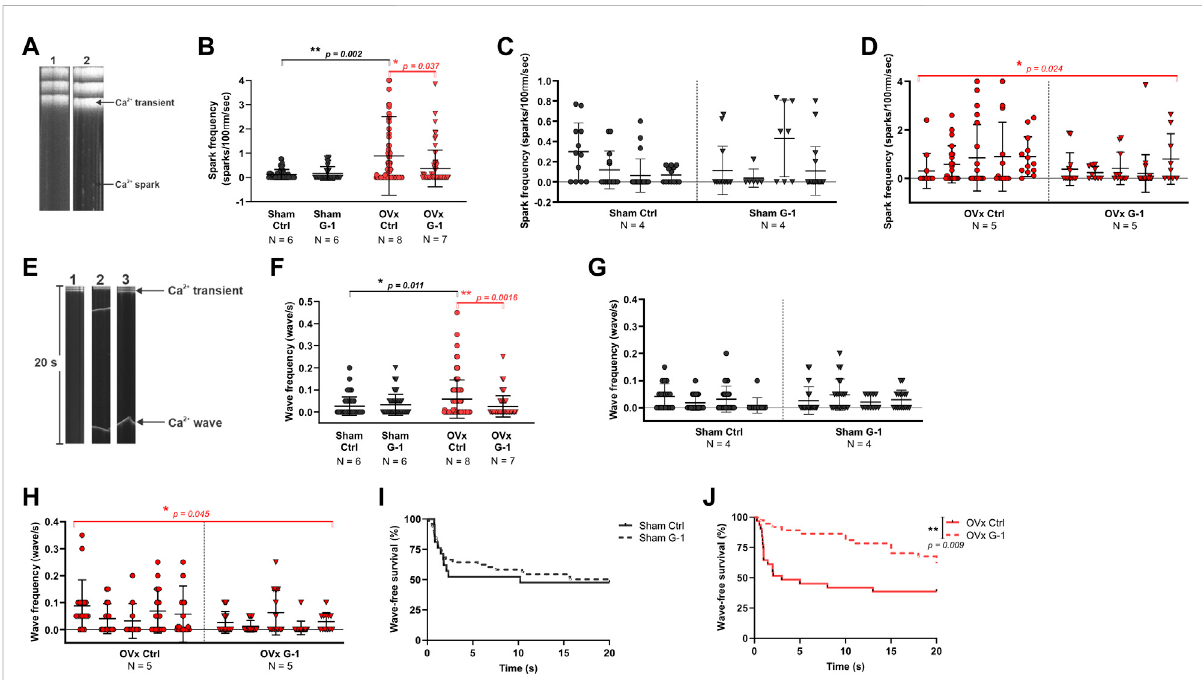
FIGURE 4 The effect of GPER modulation on spontaneous Ca 2+ release from the SR. (A) Line scan images of sham and OVx cardiomyocytes loaded with Fluo-4. (B) Spark frequency increased in OVx compared with sham and reduced following GPER activation in OVx cells. Mean ± SD. Mann-Whitney test.* p < 0.05,** p < 0.01,valuesasindicated. (C) Nestedanalysesofsparkfrequencyinshamand (D) OVxcardiomyocytesfollowingGPERactivation. Mean±SD.Nestedt-test.* p < 0.05,valueasindicated. (E) Linescanofcardiomyocytes withnowaves(image 1),multiplewaves(image2)anda singlewavewithlongerwave-freesurvivaltime(image3). (F) WavesfrequencyincreasedinOVxcomparedwithshamanddecreasedfollowingGPER activation in OVx. Mean ± SD. Mann-Whitney test. * p < 0.05, ** p < 0.01, values as indicated. (G) Nested analyses of wave frequency in sham and (H) OVx following GPER activation. Mean ± SD. Nested t-test. * p < 0.05, value as indicated. (I) Wave-free survival time of sham cells was not affected by G-1but (J) improvedfollowingGPERactivationinOVx.Mean±SD.Log-ranktest.**p < 0.01.Shamctrln/N=49/6,shamG-1n/N=45/6;OVxctrln/ N = 71/8, OVx G-1 n/N = 64/7. For nested analyses: Sham ctrl n/N = 28/4, sham G-1 n/N = 30/4; OVx ctrl n/N = 49/5, OVx G-1 n/N = 46/5